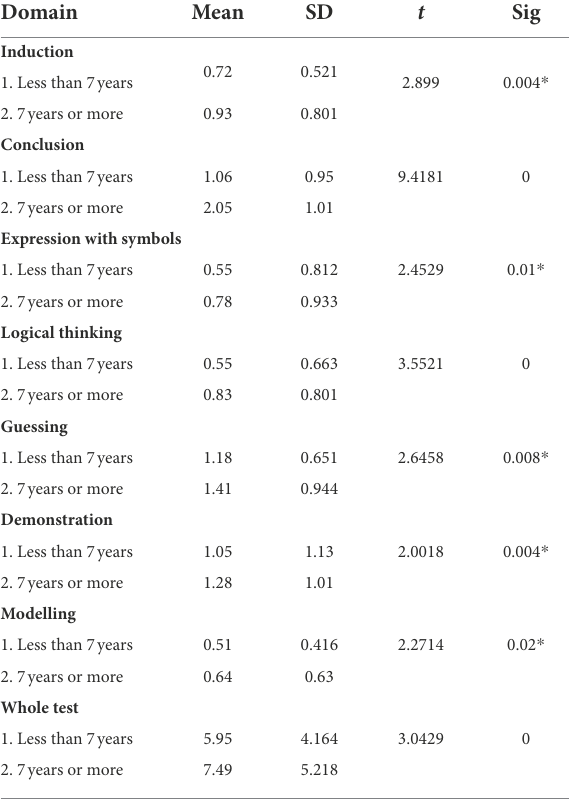
TABLE 4 Independent samples t -test for the differences in the mathematical thinking skills test based on the participants’ years of